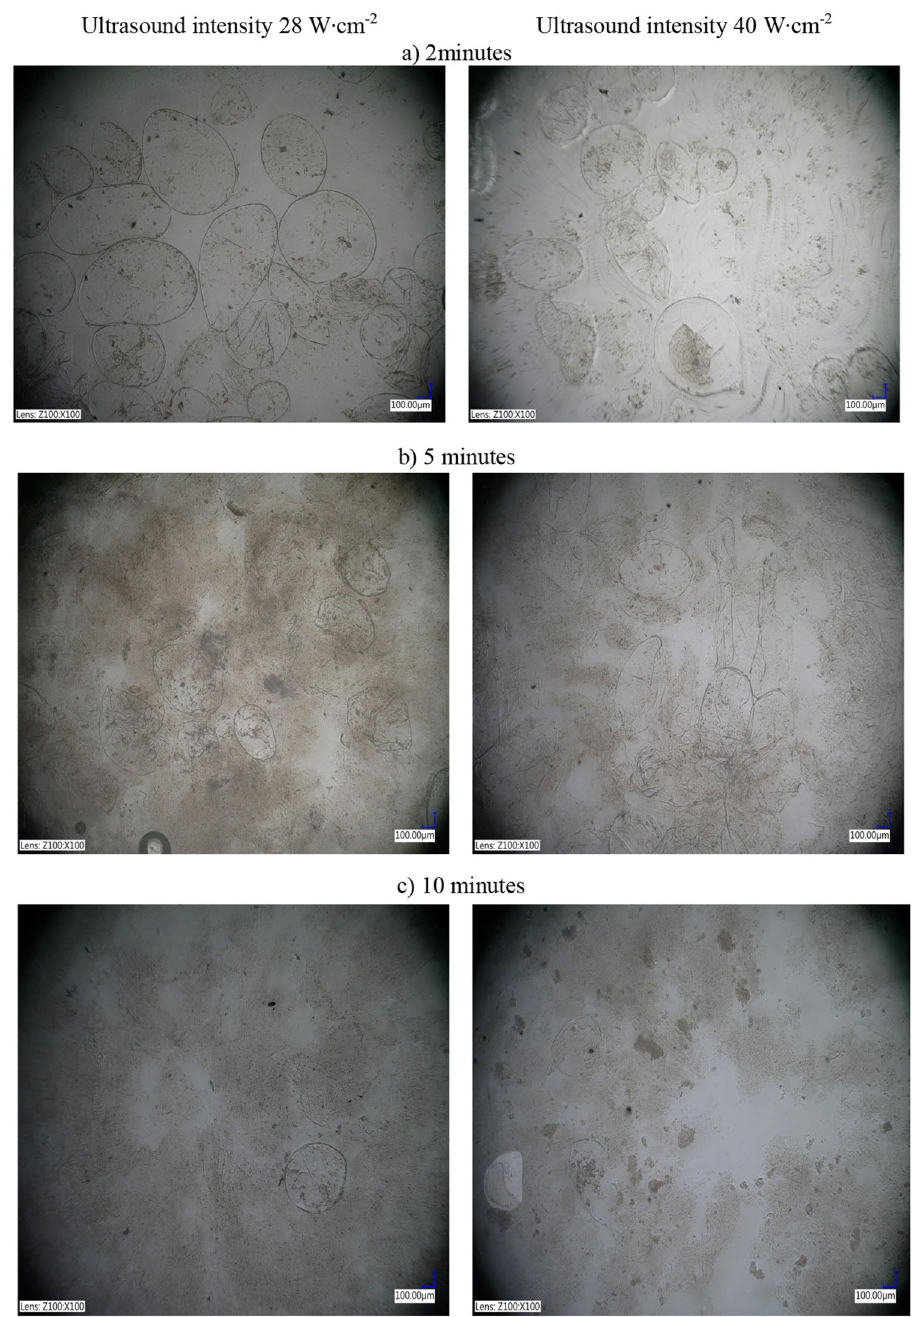
Figure 6. Microstructure of tomato juice sonicated at ultrasound intensity of 28 and 40 W cm −2 for: ( a ) 2 min, ( b ) 5 min, and ( c ) 10